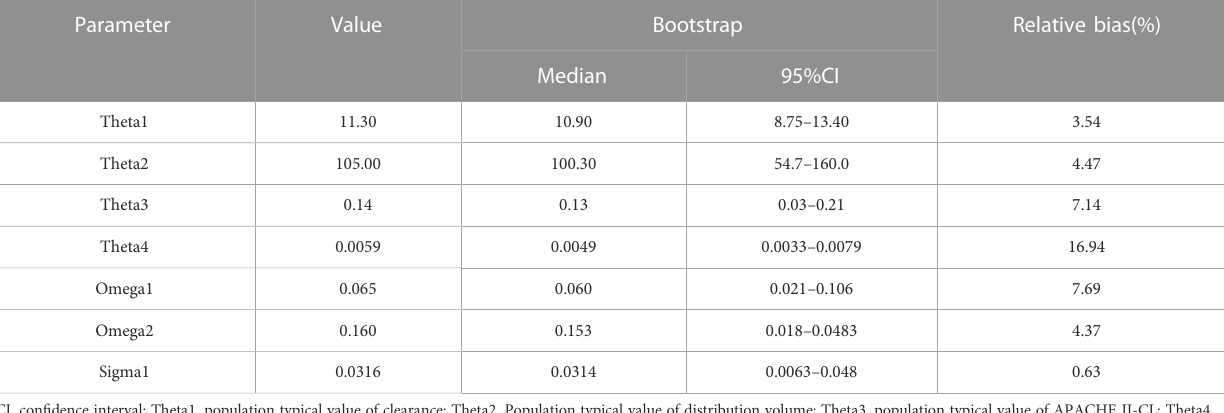
Table 4; Figure 4. The results indicated that considering a